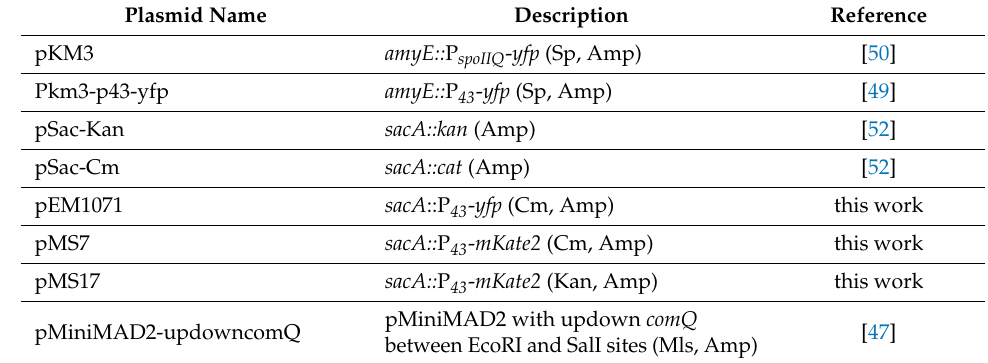
Table 2. Plasmids used in this